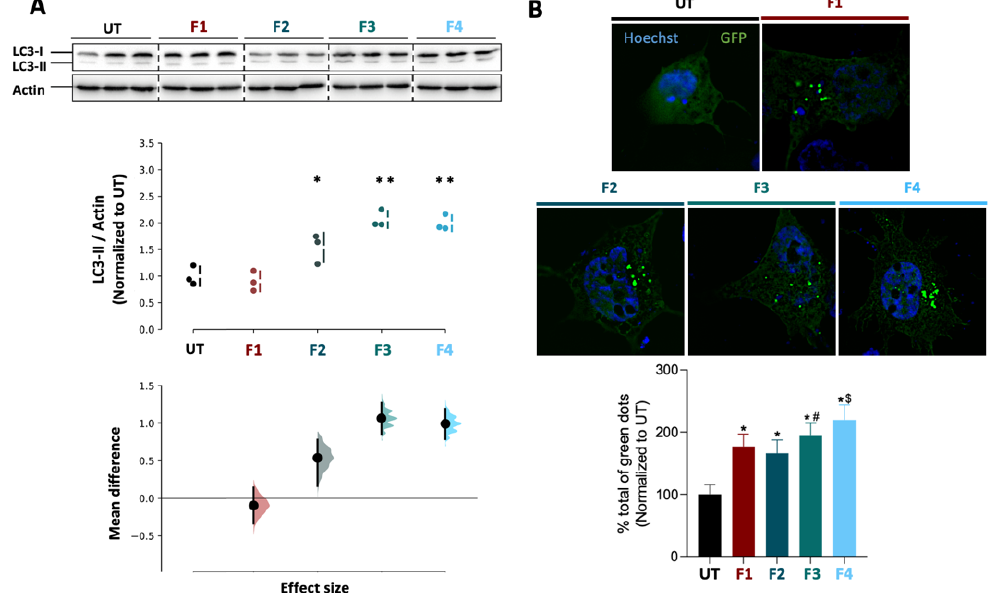
Figure 4. Biological evaluation of SLN and (un)loaded PLGA nanoparticles. ( A ) Immunoblot representative images and quantification of LC3 protein levels normalized by actin in BE (2)-M17 cells treated with F1 (red), F2 (dark blue), F3 (green) or F4 (cyan) for 24 h (1:1000). N = 3. * p < 0.05, ** p < 0.005 compared with untreated cells. ( B ) Quantification and images of LC3-positive dots per cell in BE (2)-M17 cells transfected with a GFP-LC3 plasmid for 24 h and treated with F1, F2, F3 or F4 for 24 h (1:1000). Scale bar: 10 µm. * p < 0.001 compared with untreated cells; # p < 0.05 compared with F2; $ p < 0.005 compared with F2. n = 20.